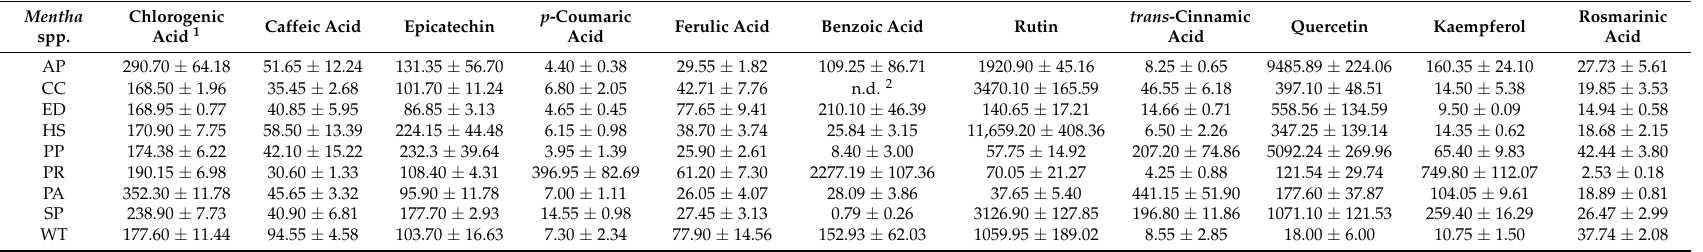
Table 1. Composition and content of phenolic compounds in different Mentha species ( µ g/g DW). Mentha spp.